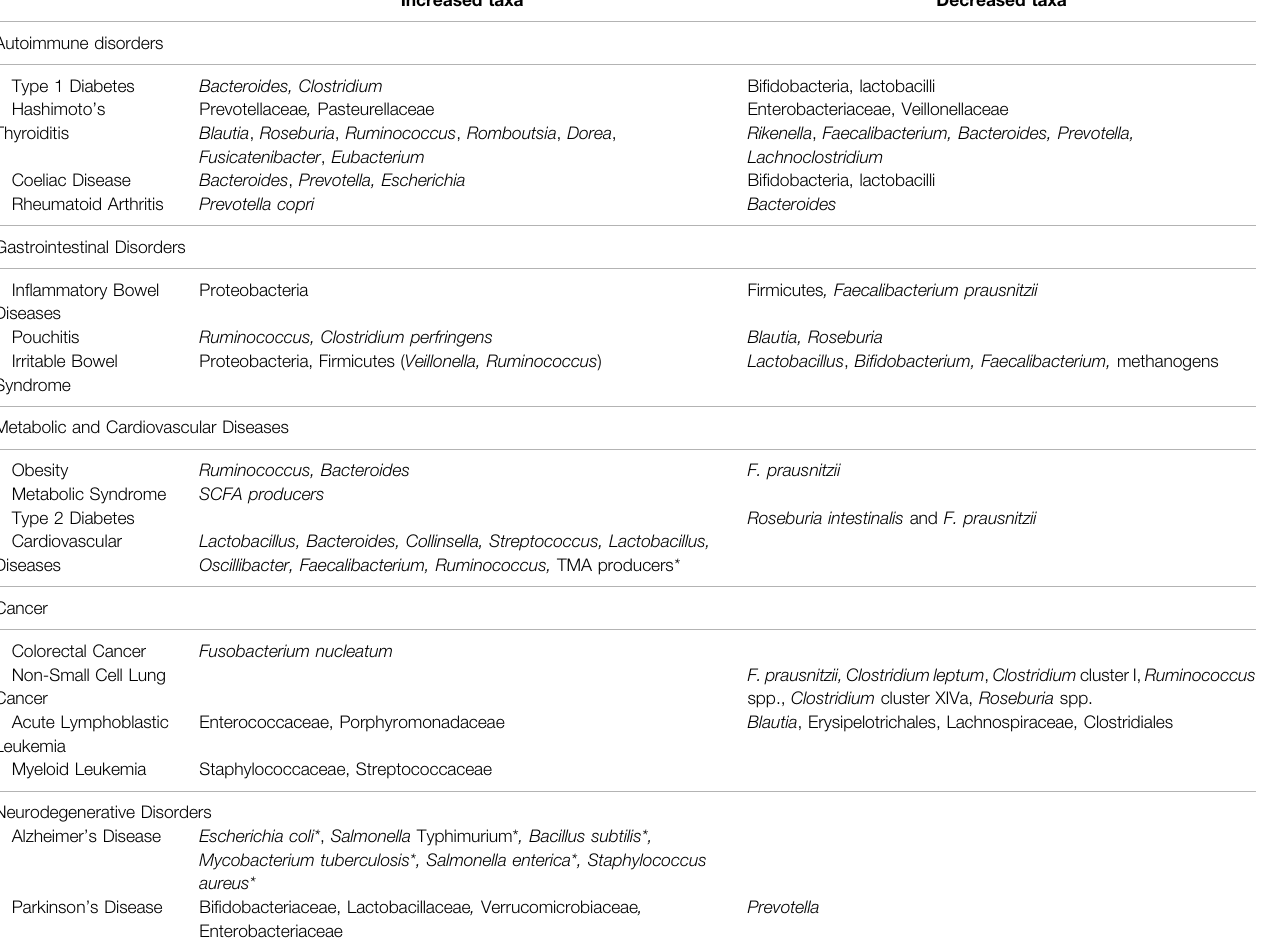
TABLE 1 | Main GM modi fi cations (referred to as taxa) observed in several non-communicable